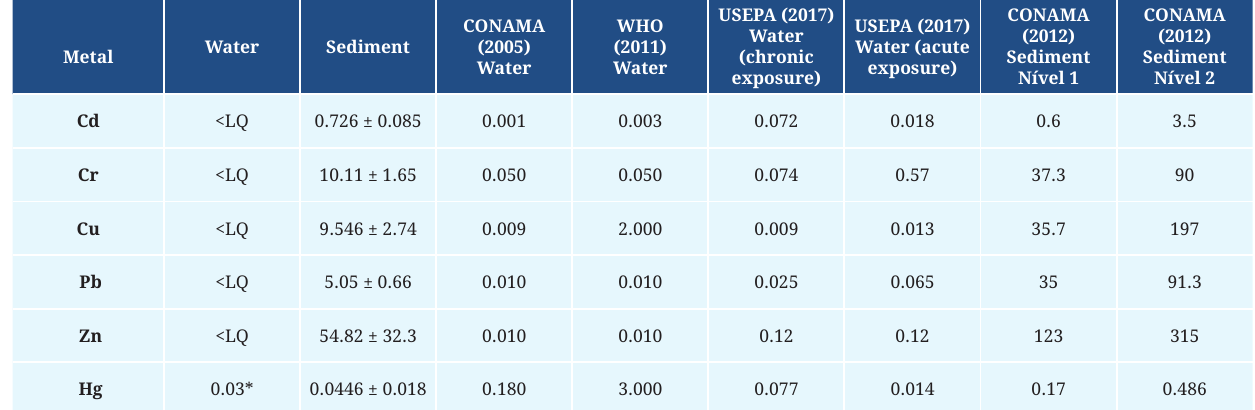
Results above the MAC were found mainly for chromium, in 18 samples: eight gills and 10 muscles. The other metals analyzed also presented samples above MAC but less frequently, being five samples for cadmium, three for zinc, two for mercury and one for copper and lead. Except for Prochilodus lineatus , the other species analyzed presented samples above MAC. Hypostomus ancistroides presented values above MAC for two gill samples (Tab. 2) and for all metals (except lead) in the muscle samples (Tab. 3), as established Resolution 42/2013 (Anvisa, 2013) and by the Ordinance nº685/1998 (Anvisa, 1998).